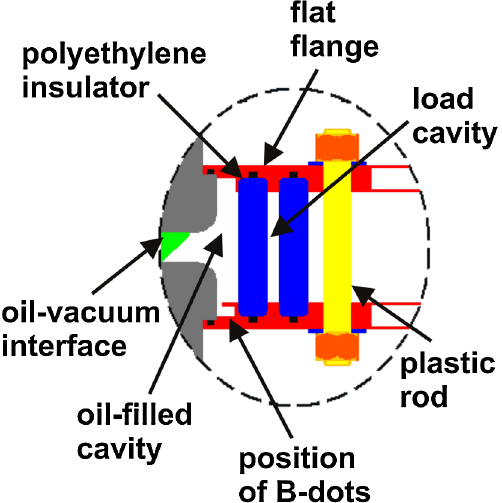
FIG. 2. (Color) Design of the load in tests of separate